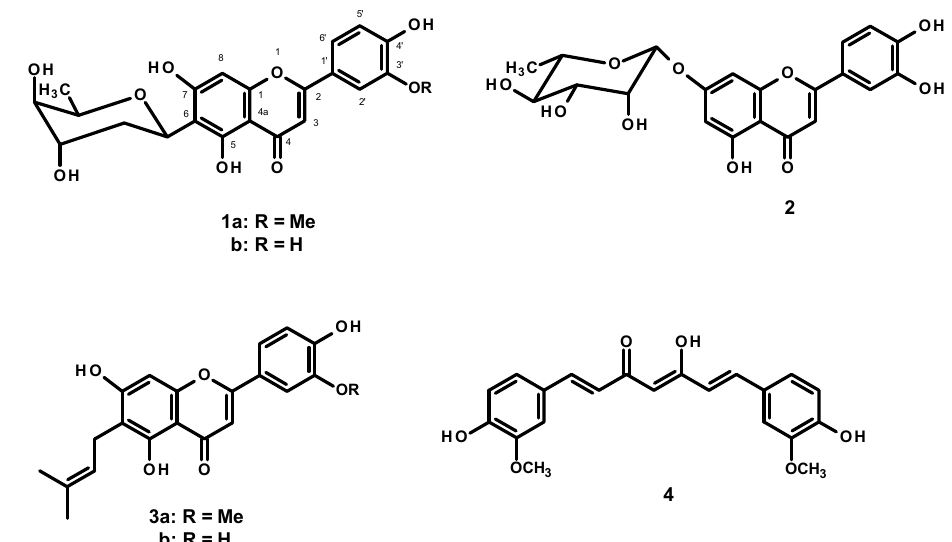
Figure 8. Structures of flavone constituents ( 1a , 1b , 2 , 3a and 3b ) of A. philoxeroides and curcumin ( 4 ).